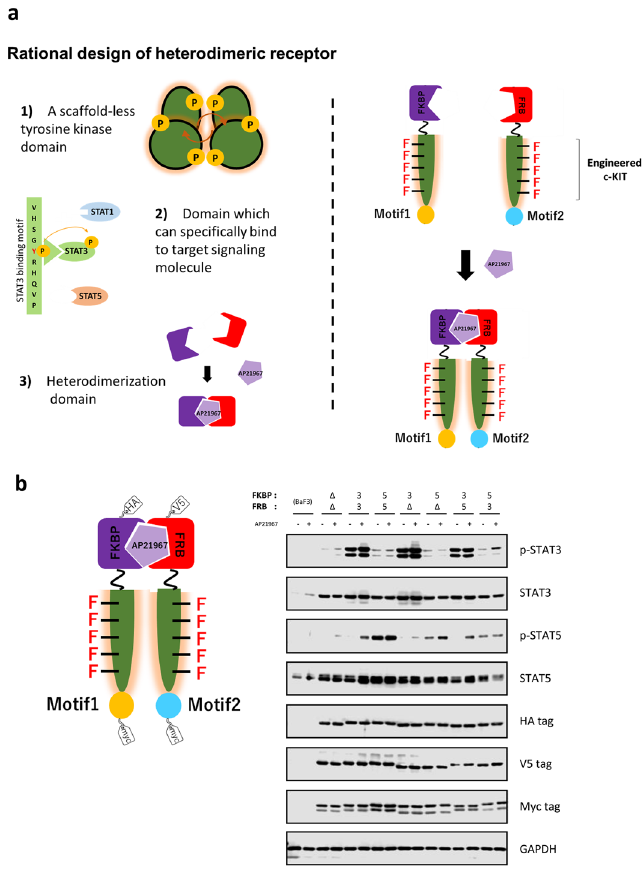
Figure 1. Rational design of heterodimeric designer receptors. ( a ) The designer receptors consist of the following 3 parts; 1) an engineered scaffold-less c-KIT which can phosphorylate the tyrosine motif, 2) a tyrosine motif, which recruits a target signaling molecule when phosphorylated, and 3) a small molecule-responsive heterodimerizing domain (e.g. AP21967-responsive FKBP/FRB T2098L complex). ( b ) The activation profiles of designer receptors without membrane localization. The STAT3- and STAT5-binding motifs were connected on either FKBP chimera or FRB chimera. The symbols Δ, 3, and 5 mean no motif, the STAT3-binding motif, and the STAT5-binding motif, respectively. In western blotting, parental Ba/F3 and the transduced cells were unstimulated (−) or stimulated with 50 nM AP21967 (+). Phospho-STAT3, whole STAT3, phospho-STAT5, whole STAT5, HA tag (FKBP chimera), V5 tag (FRB chimera), Myc tag (both FKBP and FRB chimeras; upper and lower bands, respectively), and GAPDH (loading control) were detected using corresponding primary antibodies. Full-length blots are presented in Supplementary Fig.